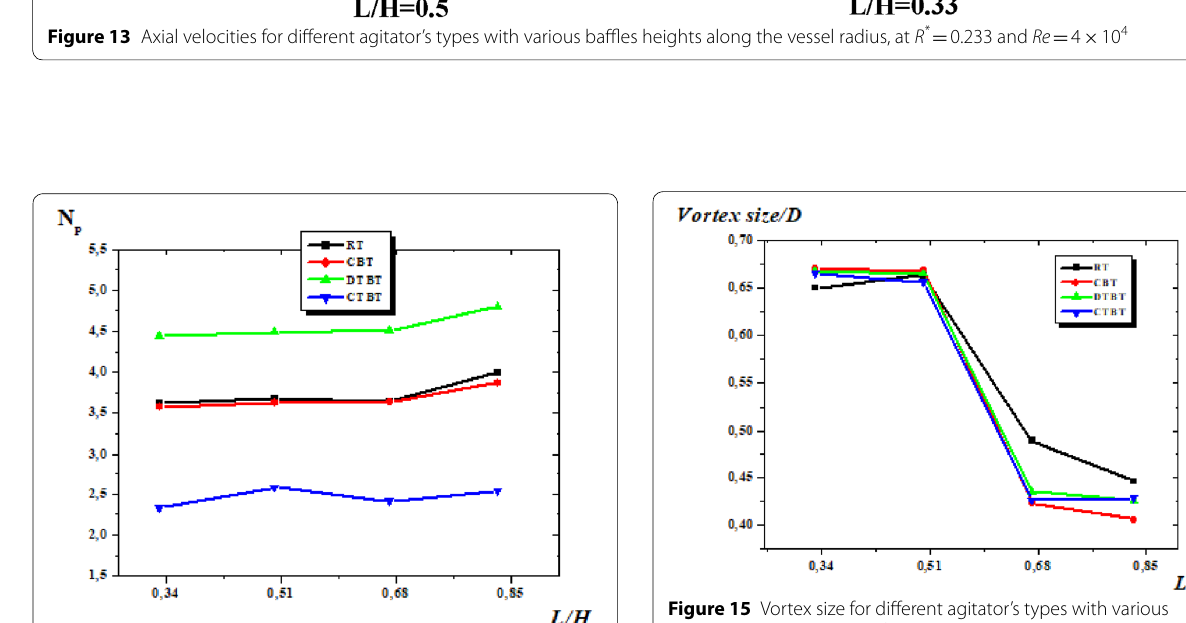
Figure 14 Power number for different agitator’s types with various baffles heights, Re